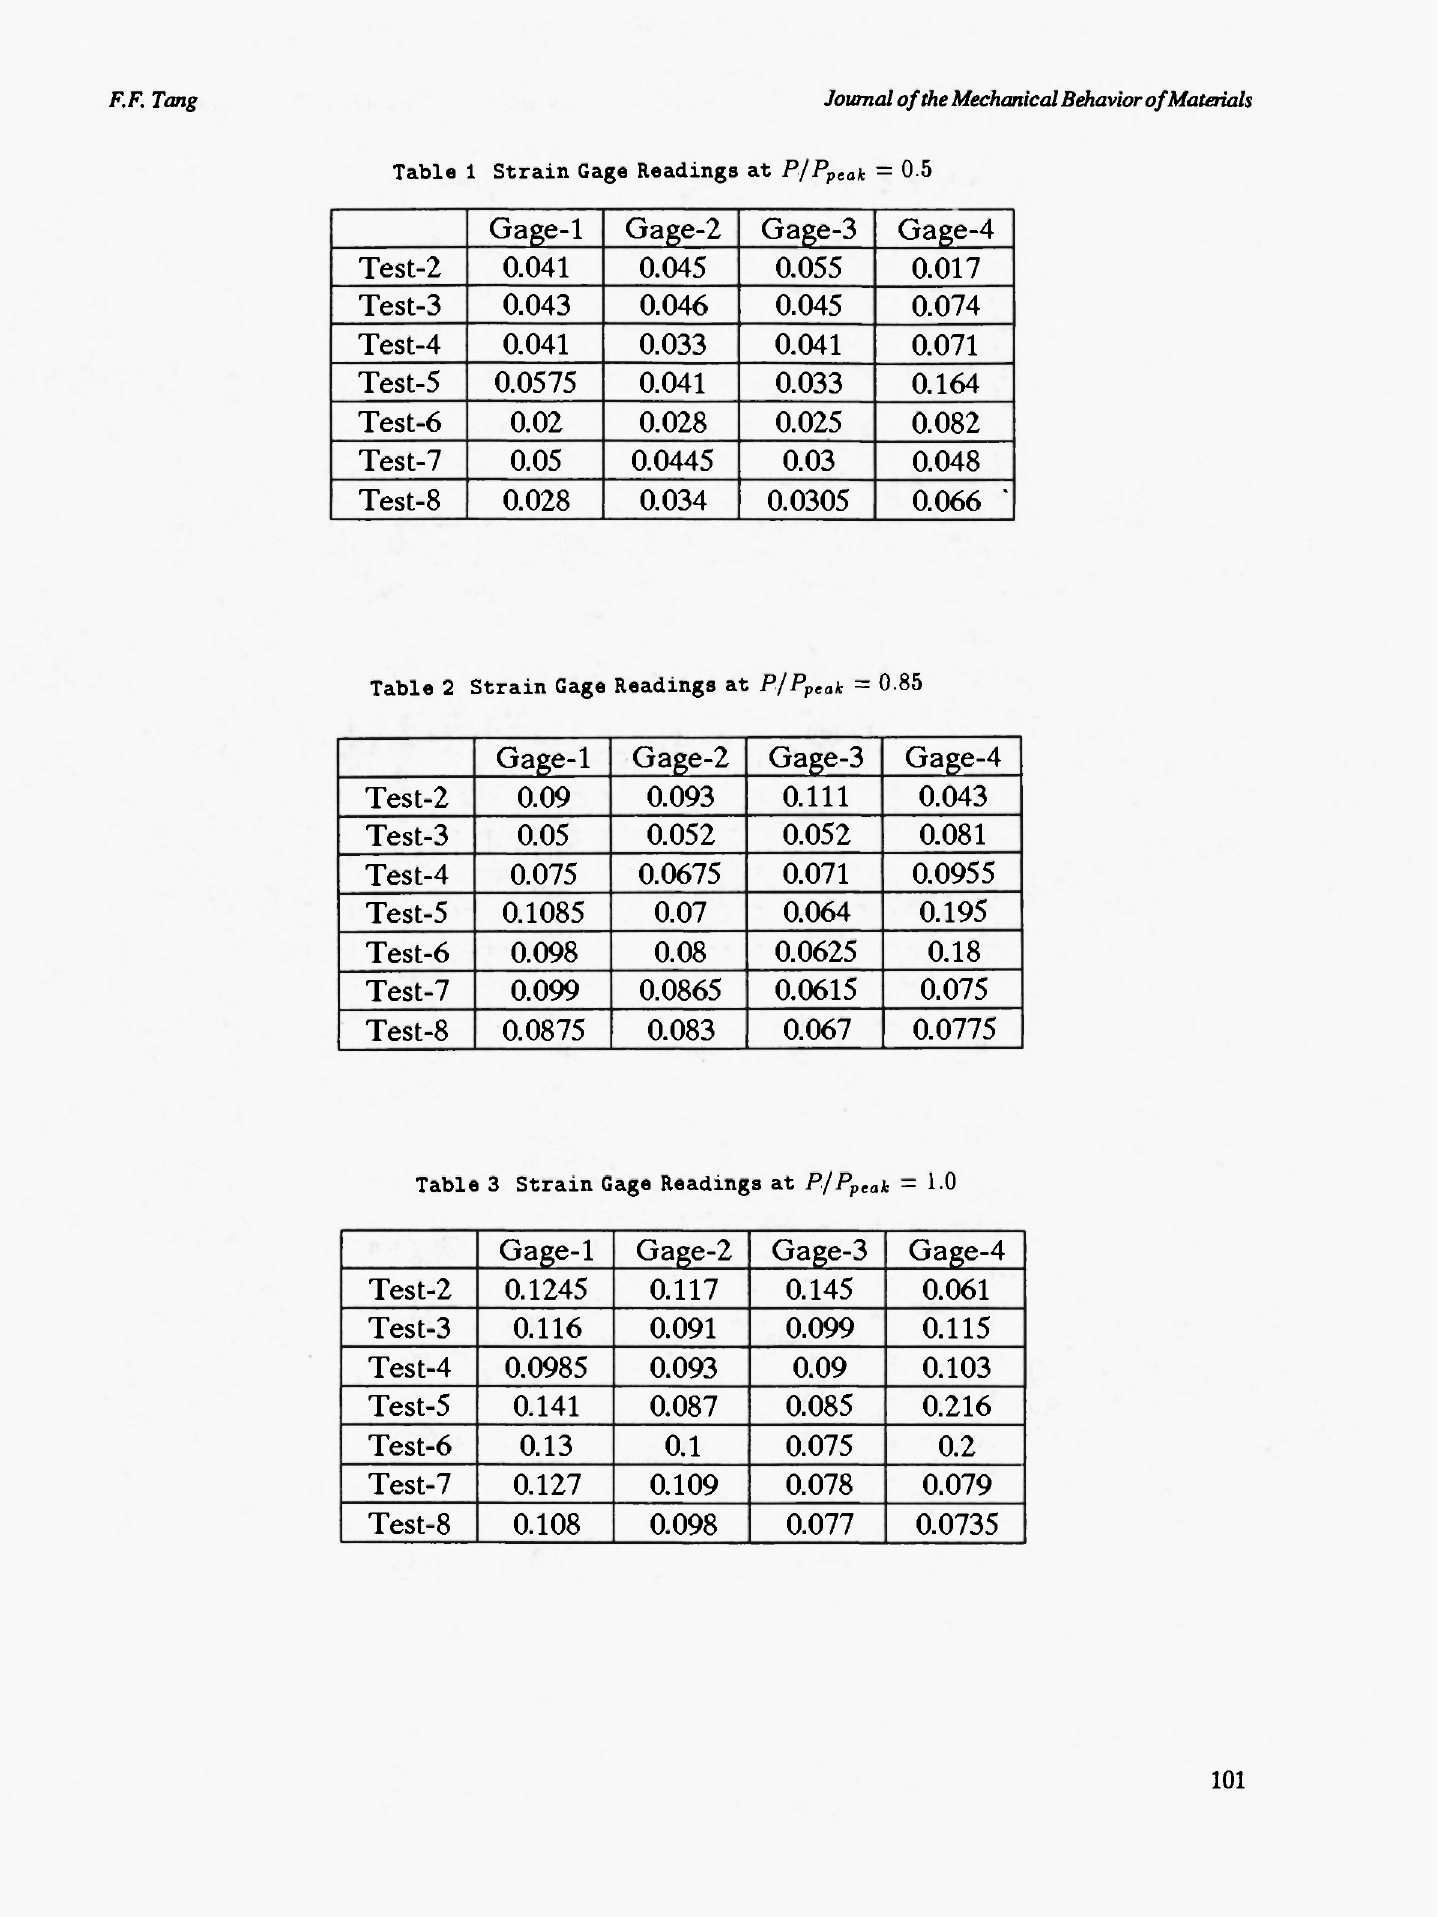
Table 2 Strain Gage Readings at P/P pea